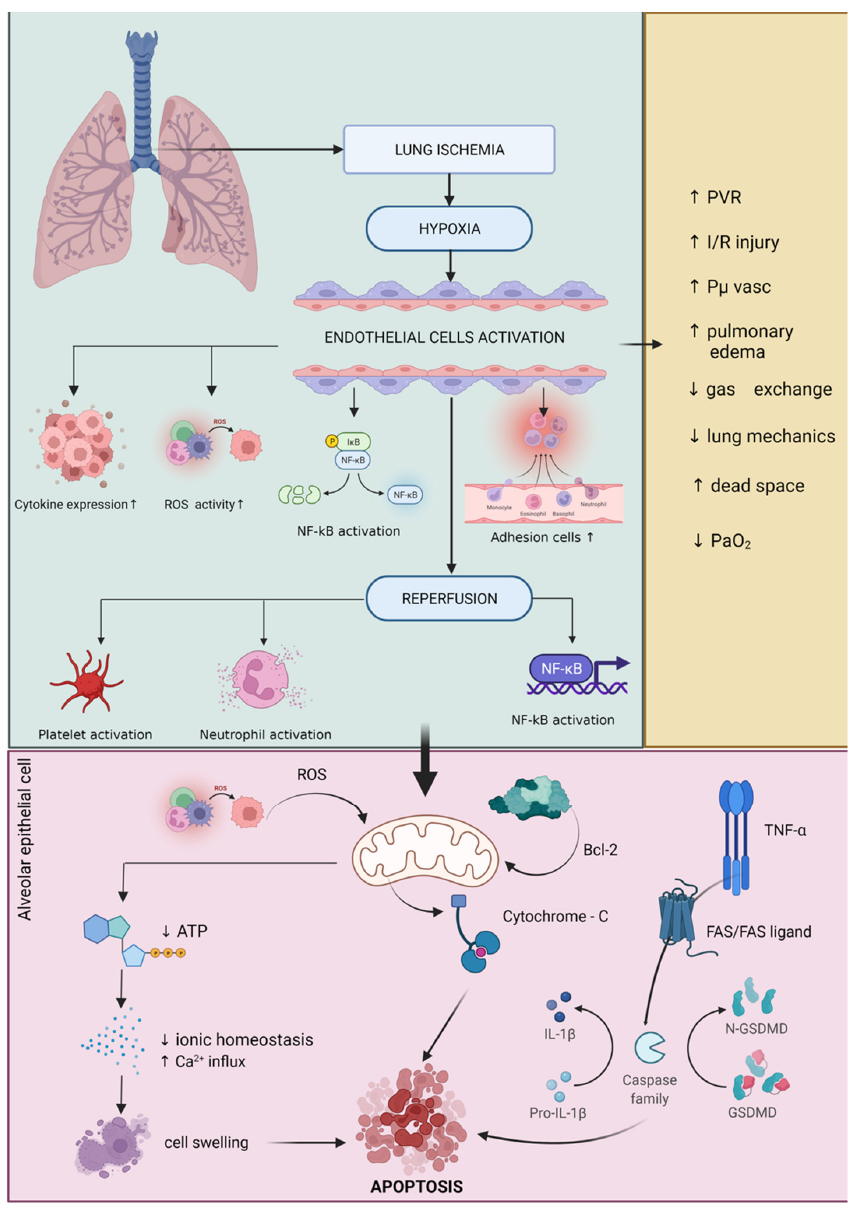
Figure 1. Schematic representation of lung ischemia–reperfusion injury. Green border: Lung ischemia causes a high degree of hypoxia that directly affects endothelial tissue with cytokine activation, increased cell adhesion activity, NF-κB activation, and accelerated generation of reactive oxygen species (ROS). Following reperfusion, a number of other biological mechanisms responsible for increasing pro-inflammatory status (e.g., NF-κB activation), platelet activation, and neutrophil activation. Pink border: these mechanisms directly affect cellular activity by altering mitochondria- specific biochemical pathways. The direct attack of ROS on the mitochondria lowers ATP biosynthesis and affects mitochondrial electrolytic homeostasis, especially by increasing the influx of Ca 2+ leading to cell swelling and apoptosis. Another biochemical pathway with a significant negative effect on mitochondrial activity is the activation of TNF-α, which activates caspase family via FAS/FAS-ligand and generates increased amounts of IL-1β by catalyzing pro-IL-1β factor. Another mechanism found in cellular apoptosis due to damage to alveolar epithelial cells is the direct action of bcl-2 on the mitochondria leading to cytochrome-C overexpression and finally cellular apoptosis. Yellow border: all these biochemical mechanisms that are involved in the process of mitochondrial and cellular denaturation induced by the phenomenon of ischemia–reperfusion of lung tissue lead to increased pulmonary vascular resistance (PVR), increased pulmonary edema, increased oncotic pressure of the vascular capacity, decreased lung mechanics, increased dead space